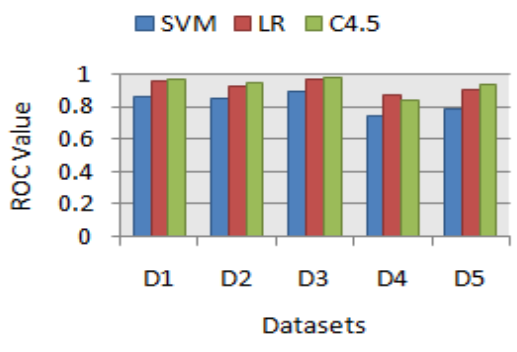
Figure 4. Prediction results of machine learning techniques in terms of ROC value for different datasets based on temporal, spatial and data-centric social contexts